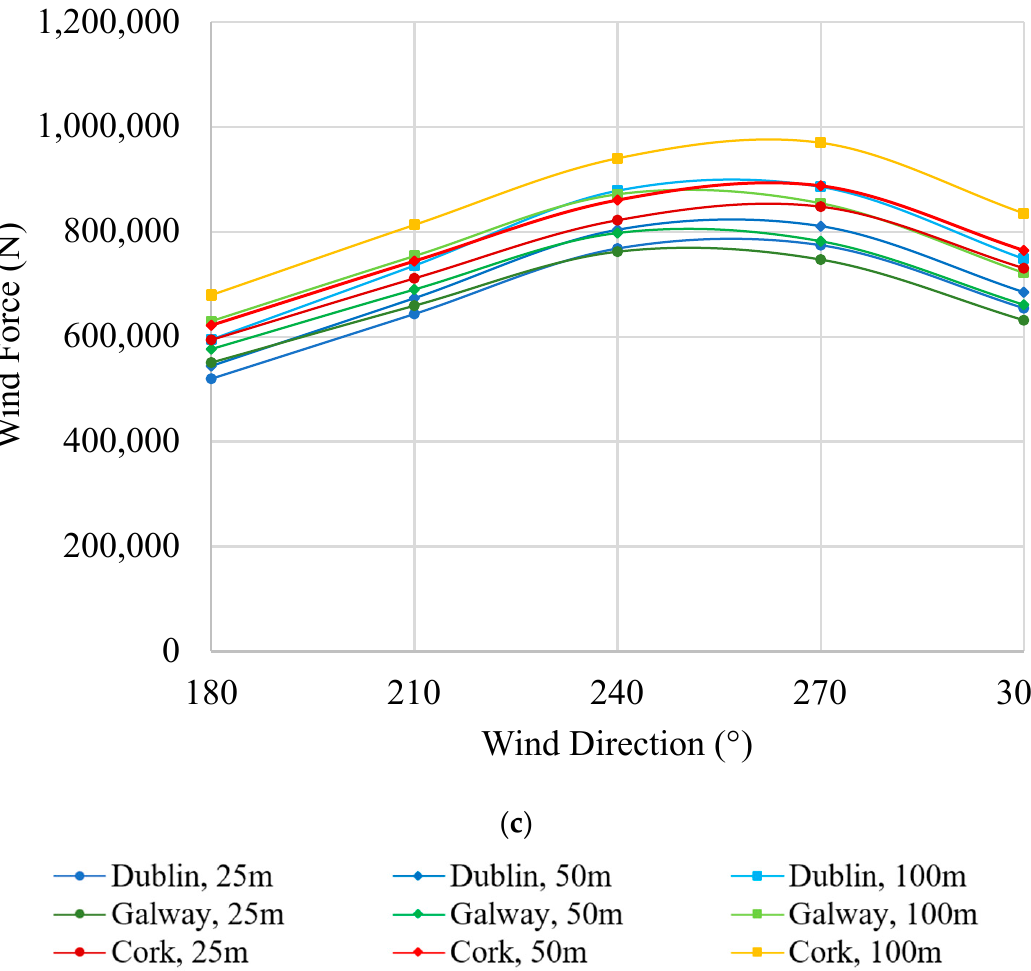
Figure 2. Wind force plotted against wind direction for ( a ) Deck in the x-direction; Wind force acting on the deck in the x-direction; ( b ) Deck in the z-direction; Wind force acting on the deck in the z-direction; ( c ) Piers in the x-direction; Wind force acting on the piers in the x-direction. Each of the Eurocode cases, regardless of whether the x-direction or the z-direction is examined, follows the same shape trend: skewed slightly to the left due to the uneven distribution of wind across different directions. This is due to the uneven distribution of the wind forces with an emphasis on the directions clockwise from due north of the prevailing wind. This is caused by the directional factors, c dir , for the angles 180 ◦ to 300 ◦ clockwise from due north being 0.85, 0.93, 1.00, 0.99, and 0.91, respectively. The values of net wind force in the x-direction vary from 572,436 N to 1,060,299 N, with a mean of 812,221 N. In the z-direction, the values vary between 1,321,005 N and 2,446,845 N, with a mean of 1,869,964 N. The wind force in the z-direction represents the uplift as a result of the horizontal force in the x–y plane, with forces upwards being positive and forces downwards being negative. The reason for these high values is that in the absence of an equation for uplift, the characteristic peak velocity pressure, q p (z), for wind travelling horizontally at the reference height of the bridge, was applied to the reference area of the bridge in the z-direction, A ref,z . This represents a scenario where the wind is travelling vertically upwards at the same peak magnitude that it would horizontally: an unlikely scenario but also not the scenario being investigated. Wind in these cases is strictly travelling horizontally. However, the force coefficient in the z-direction, c f,z , is applied to reduce the net wind force in order to more realistically represent the effect that horizontal wind would have in the z-direction. For the deck cross-section in question, a value of ±